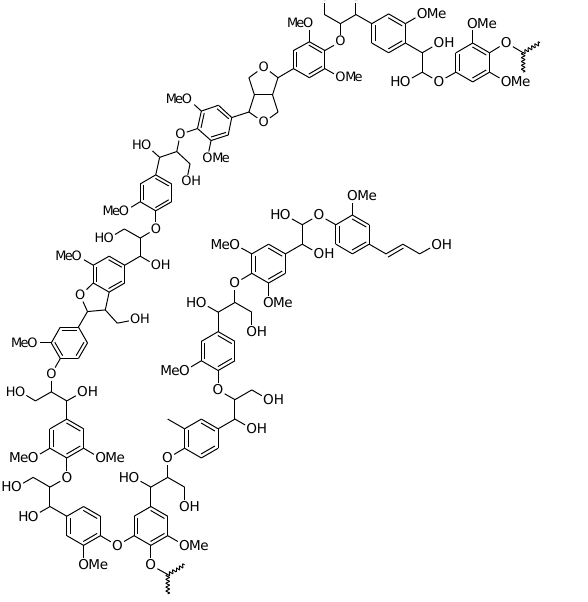
Figure 2. Lignin polymer model for a hardwood lignin, redrawn from